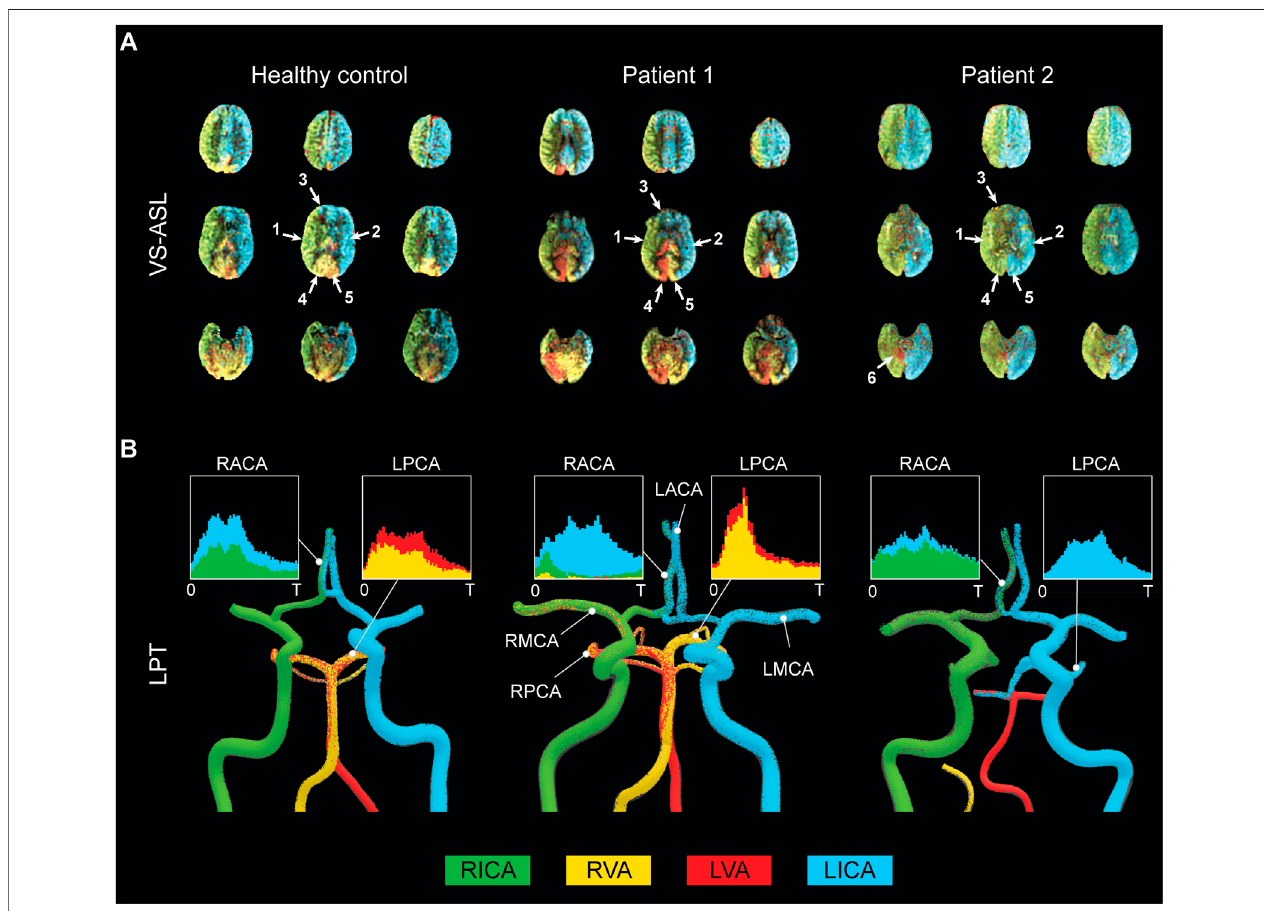
FIGURE 4 | Qualitative comparison between FBS obtained from VS-ASL and CFD LPT (A) VS-ASL images show the perfusion territories of the main neck arteries from theinferiorofthecranium (bottom rowslices) tothesuperior (toprowslices) .Theimages werecreatedbycolor-codingtheFBS mapsofthemainneckarteries onavoxel-by-voxel basis.Forvisualizationpurposes, welimited thefractionalcontributionsofeachneckarterytoapositiverangebetween0and 1.Thearrows indicate the vascular territories of the 1) RMCA, 2) LMCA, 3) RACA, 4) RPCA, 5) LPCA, and 6) cerebellum. (B) LPT analyses show the advection of particles in the large arteries of the CoW. Particles are color-coded based on the artery of origin in the neck. Histograms demonstrate mixed supply in the RACA and LPCA over the cardiac cycle T.